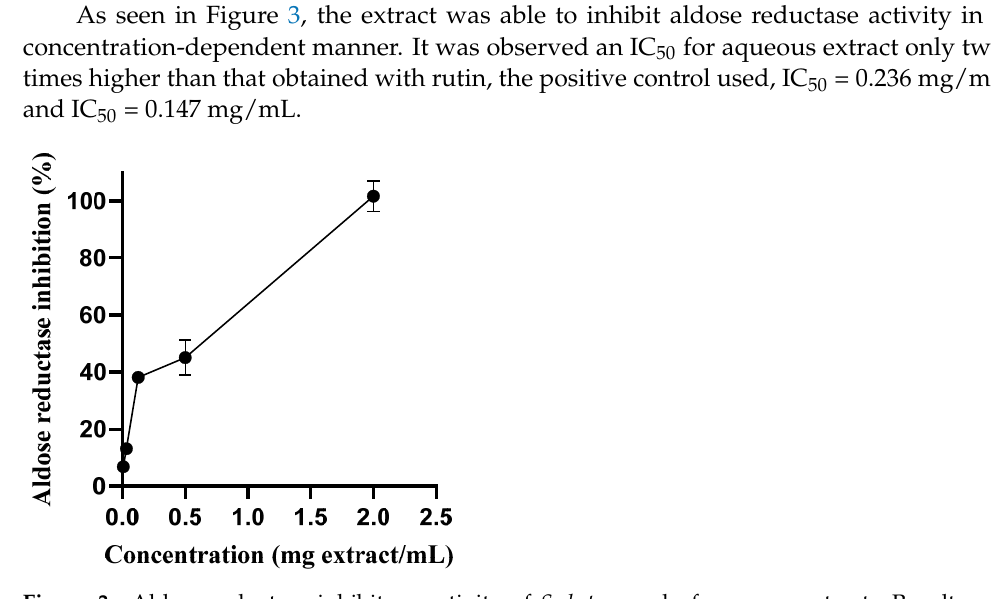
Figure 3. Aldose reductase inhibitory activity of S. betaceum leaf aqueous extract. Results are expressed as mean ± SD of six independent experiments, each performed in triplicate.